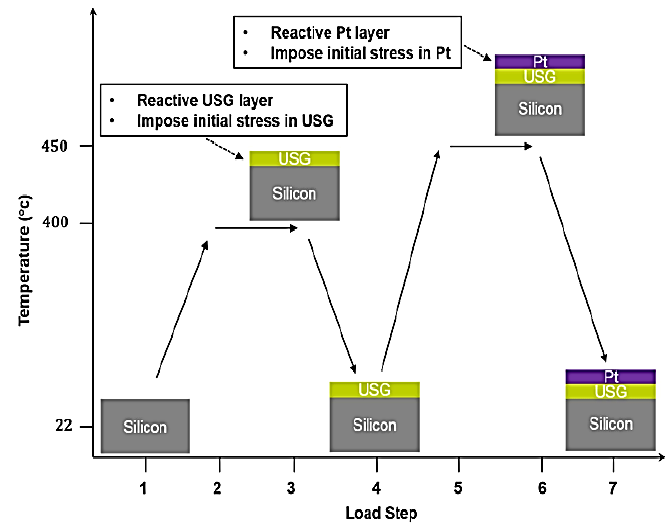
Figure 3. The whole thermal cycle used by Yao et al. [3]. Table 1. Materials ’ properties.